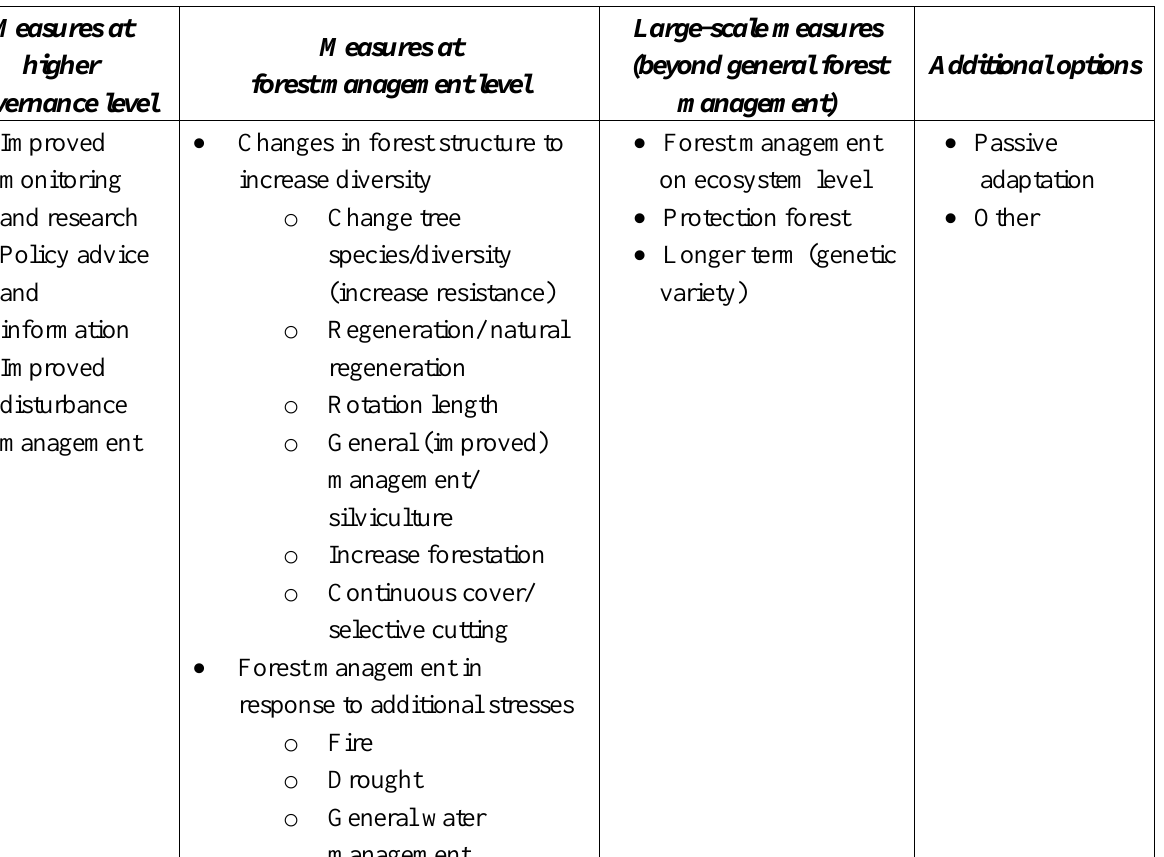
Table 1. Types of management actions, by implementing